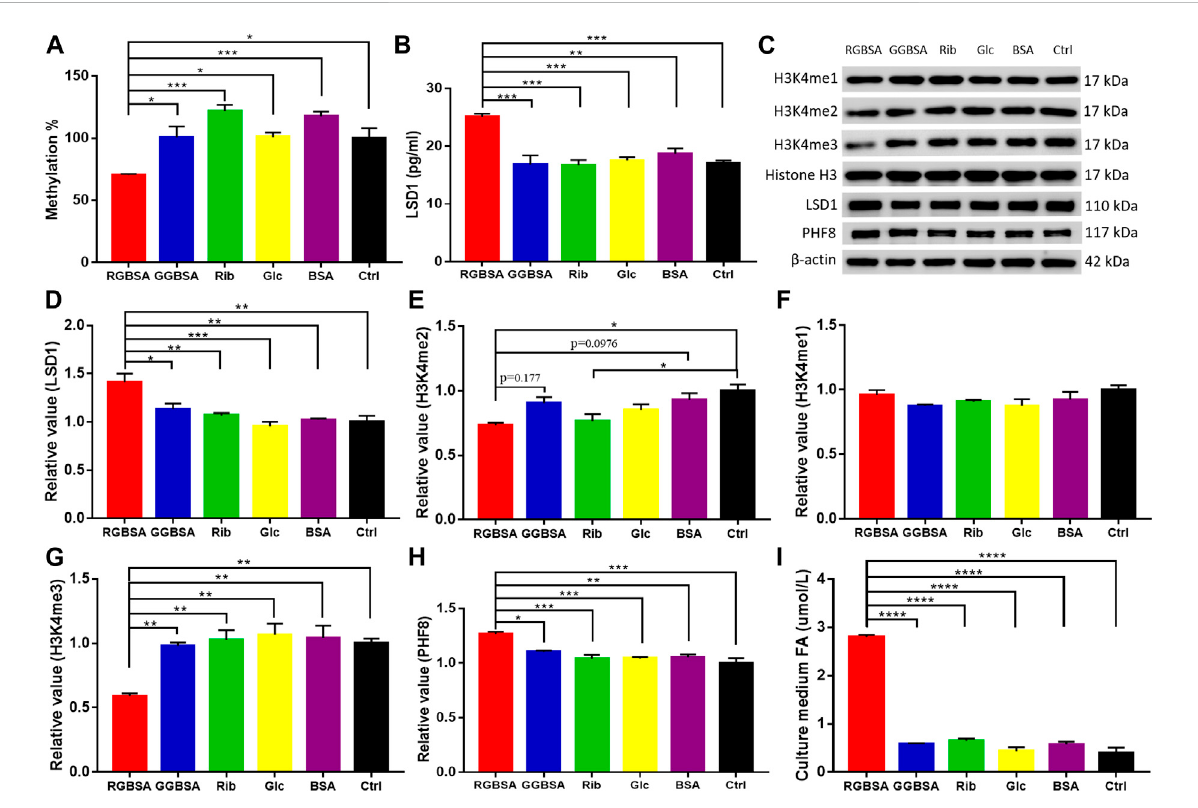
FIGURE 5 Riboglycated BSA reduces H3K4 methylation in SH-SY5Y cells. Experimental conditions were the same as in Figures 3C – H. The levels of global histone H3-K4 methylation (A) and LSD1 (B) weredetermined by ELISAs. The levels of H3K4me1, H3K4me2, H3K4me3, LSD1, and PHF8 in cells were determined by Western blot analysis (C) . Histone H3 or β -actin was used as the loading control. Quanti fi cation results are shown in (D – H) . The control values were set at 1.0. Quantitative assessment of culture medium FA levels detected by HPLC (I) . All values were analyzed by one-way ANOVA and are presented as the mean ± SEM ( n = 3). * p < 0.05, ** p < 0.01, *** p < 0.001, and **** p <